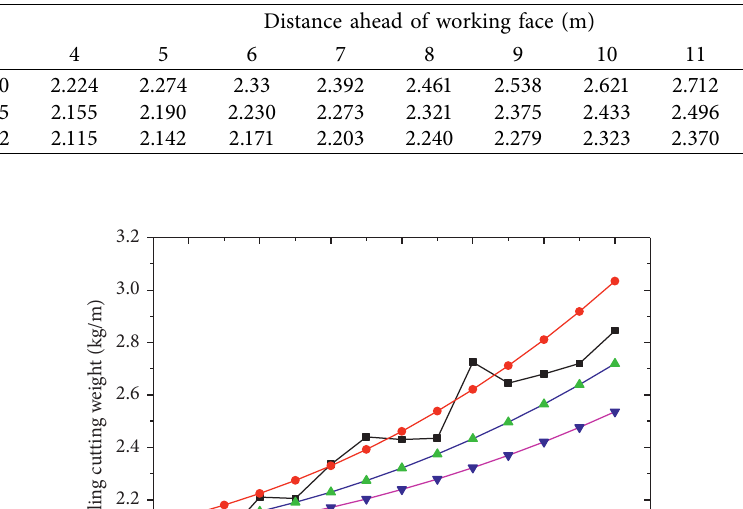
Table 6: The total drilling cutting weight (kg/m).